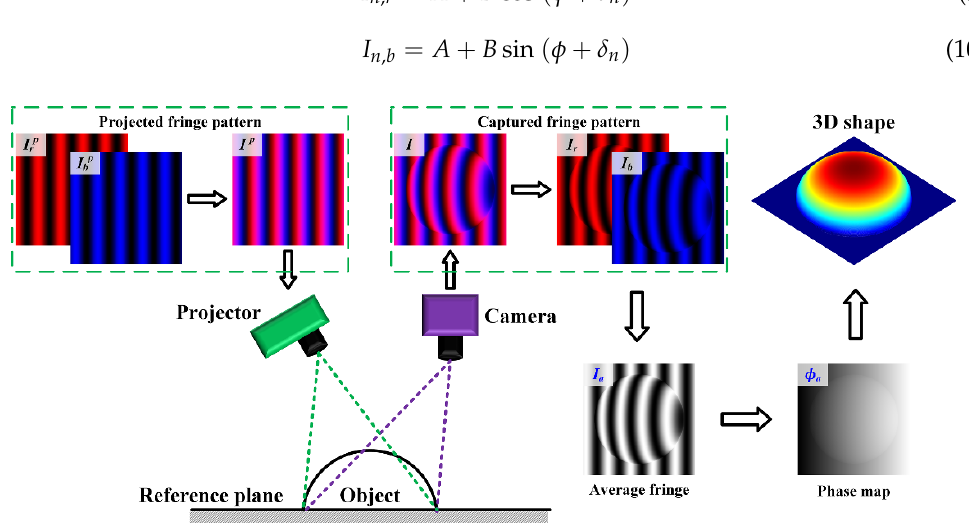
Figure 1. Principle of the proposed IDTP algorithm.